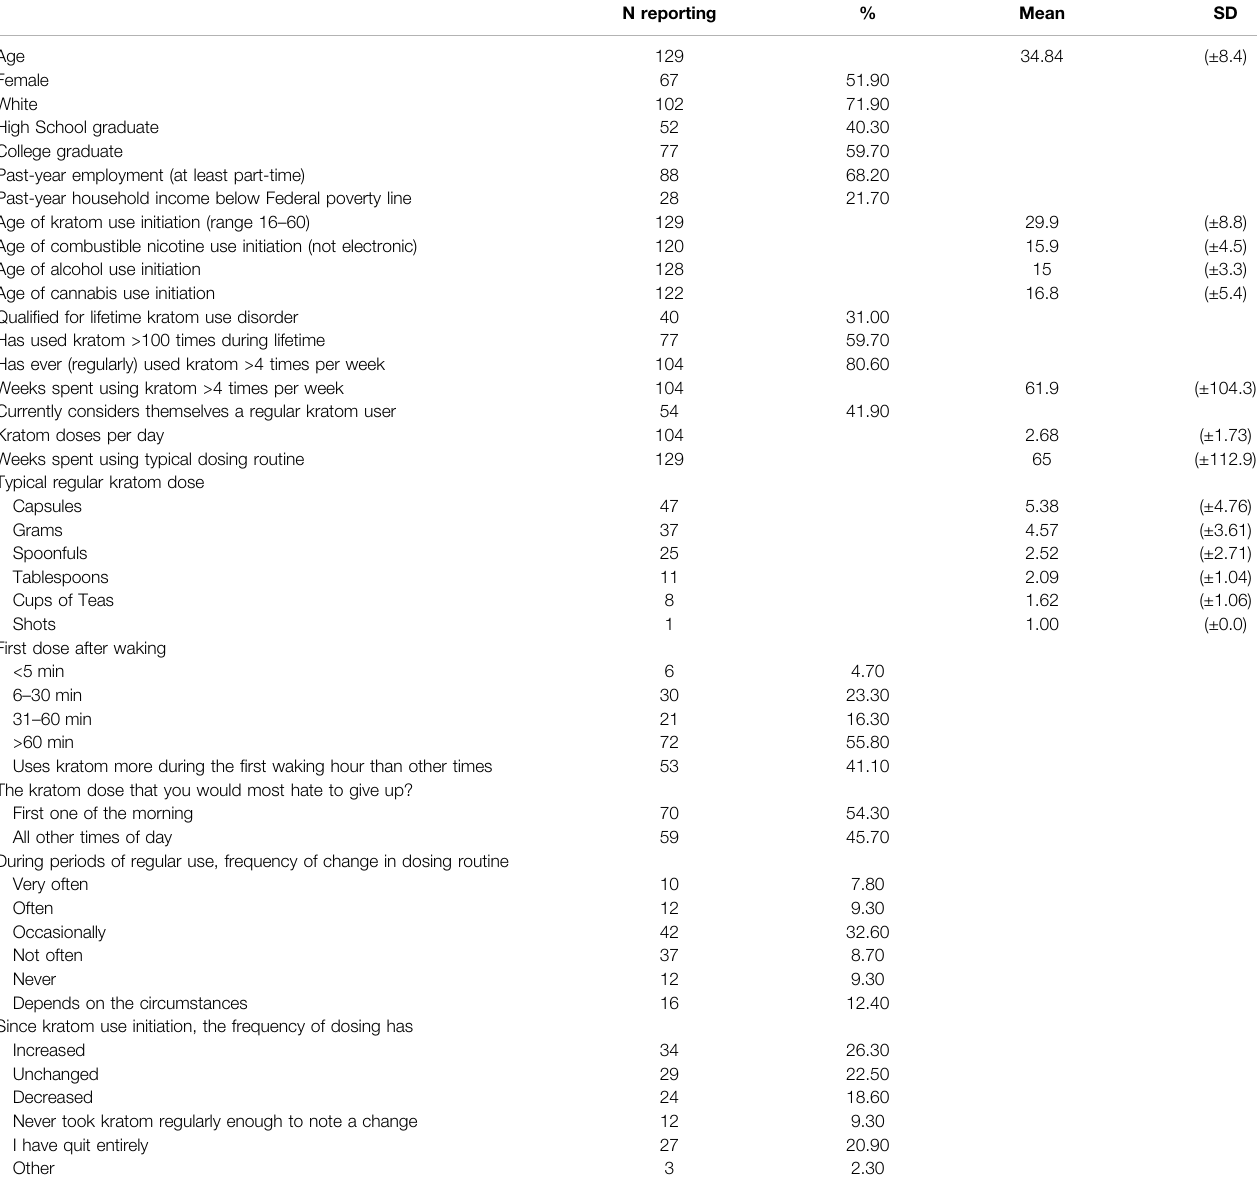
TABLE 1 | Means and proportions for sample demographic characteristics, kratom use history, typical dosing routines, and changes in kratom dosing. Total sample (n =